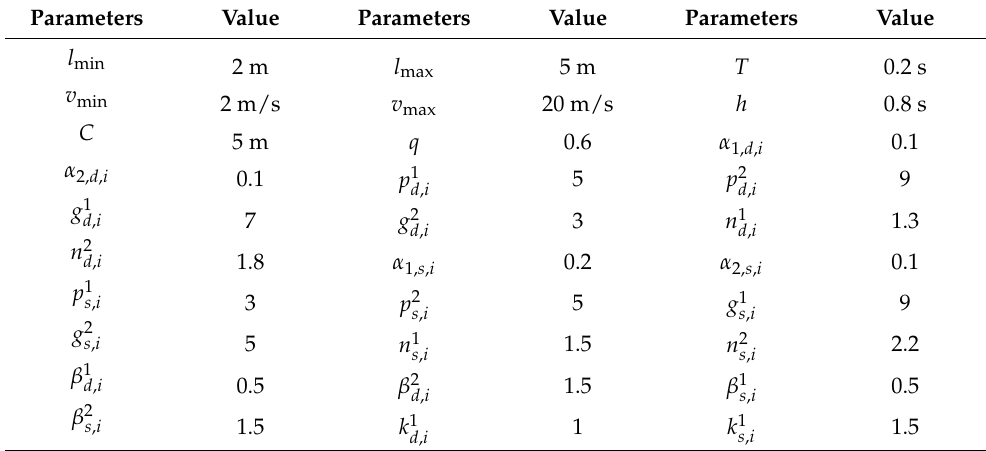
Table 2. Model and controller